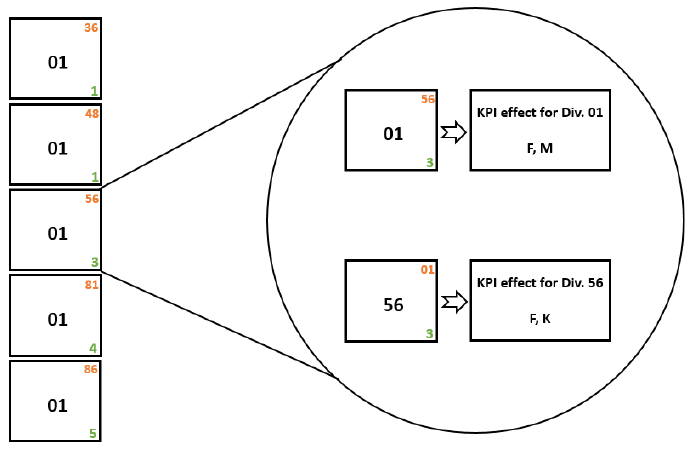
Figure 11. Zooming in level of the industrial periodic